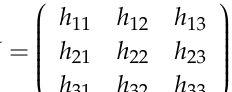
Figure 6. Feature matching between adjacent images.